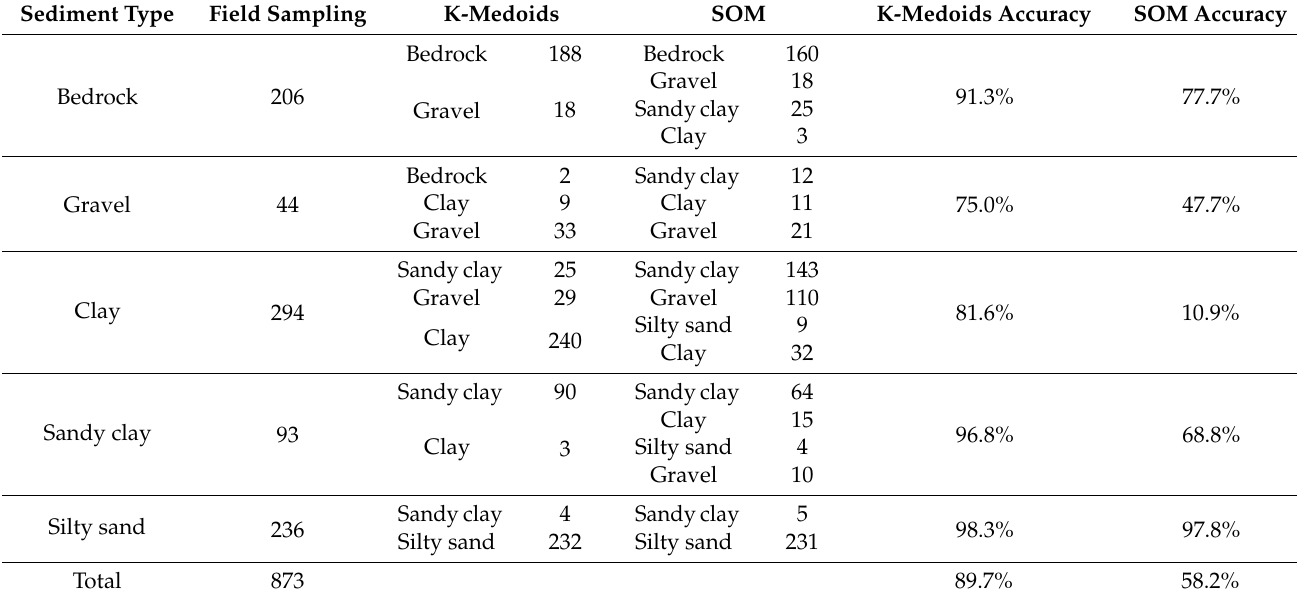
Table 4. A comparison between the classification of K-medoids algorithm and the field sampling data along the survey line when there are five